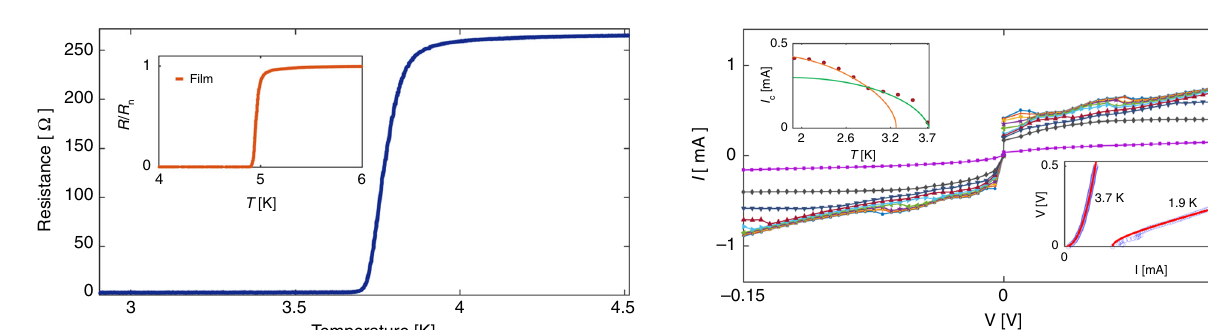
Fig. 2 Electron microscopy characterization and element analysis of Nb-coated superlattice. a SEM image of the top layer of one of the Nb-coated superlattice fl akes. b SEM of magni fi ed region with inset fi gure denoting the array arrangement of S-s-S Josephson junctions with large grains grown on the octahedron (gray diamond) with small connections formed at vertices (yellow). c HAADF image of Nb-Superlattice representative of underlying layers of surface shown in b , AuNP appear white while the silica superlattice appears gray on a black background. d EDS map with column sums of fi rst three layers (gold, red, and blue) of the Nb superlattice as indicated by the appearance of AuNP in red. e HAADF image of the same region with AuNP in white with the silica lattice in a lighter tone. f EDS highlighting the Nb spectrum K-edge peak at 16.58 KeV. Inset is a log scale of column 3 (blue), shown in d , at the same energy.